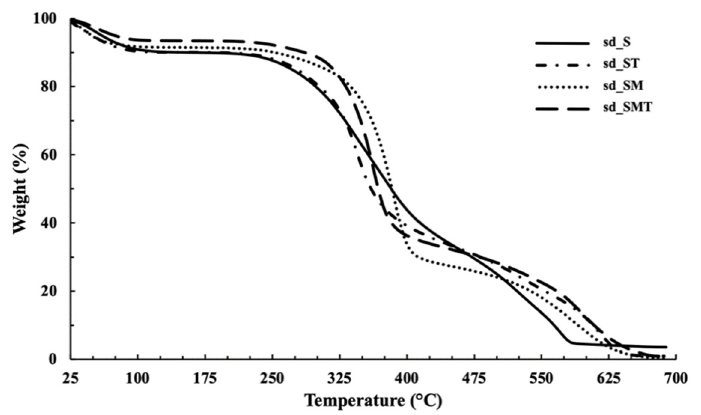
Figure 5. Thermogravimetric curves of all the spray–dried sericin